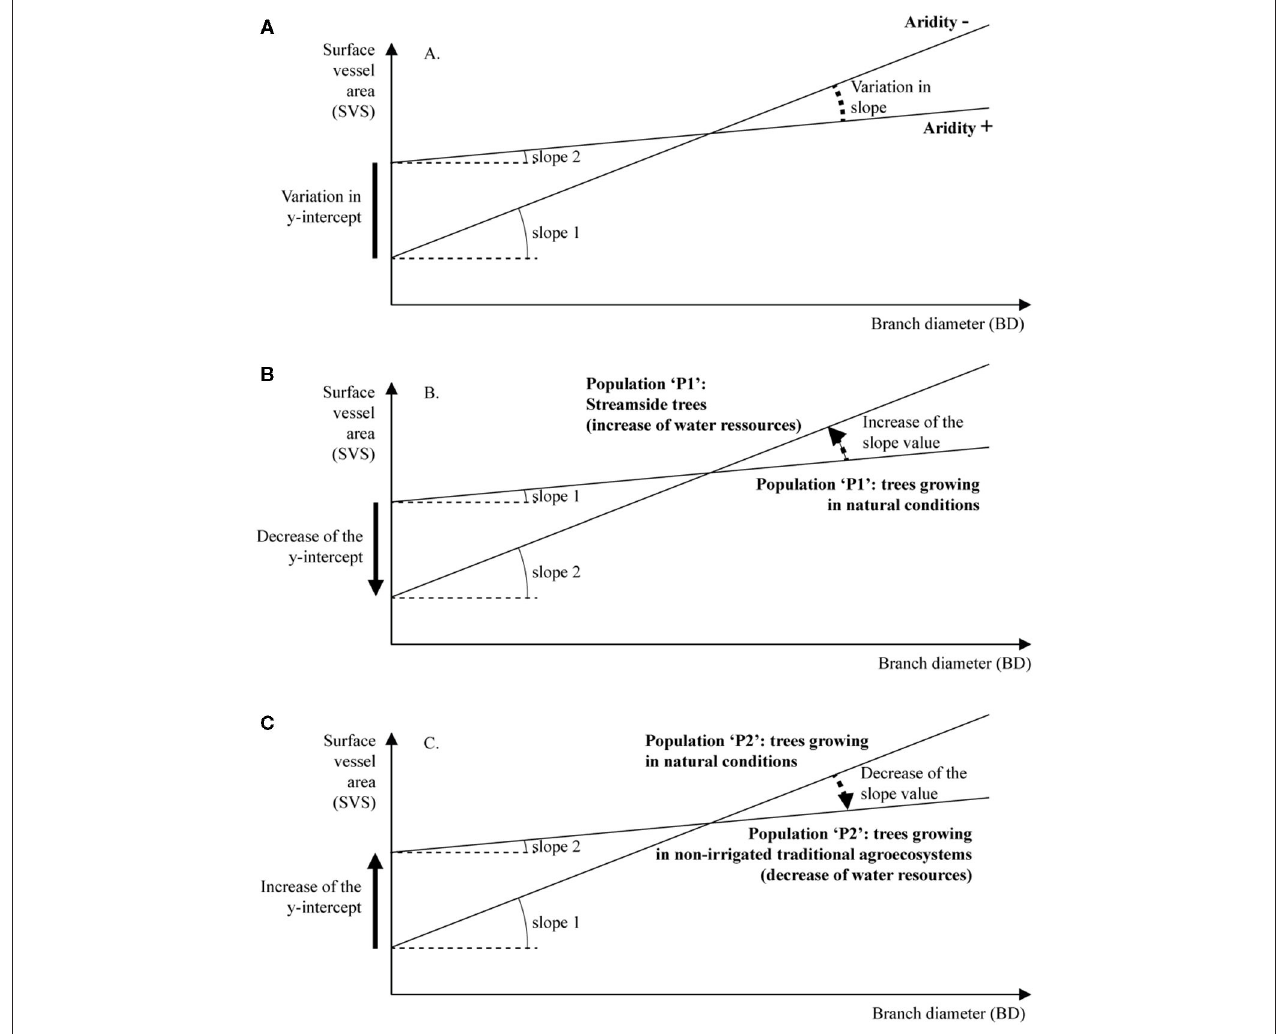
FIGURE 5 | Conceptual summary of variations in slope and intercept of linear models relating SVS and BD, according to water resources [ (A) in natural conditions, (B) in streamside conditions, and (C) in non-irrigated cultivation